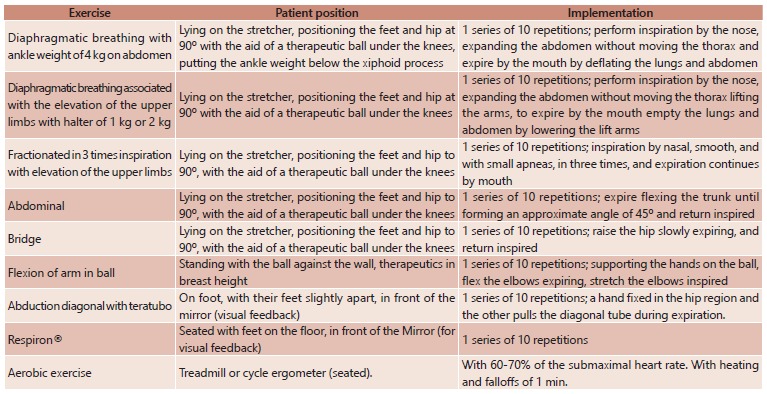
Exercise protocol